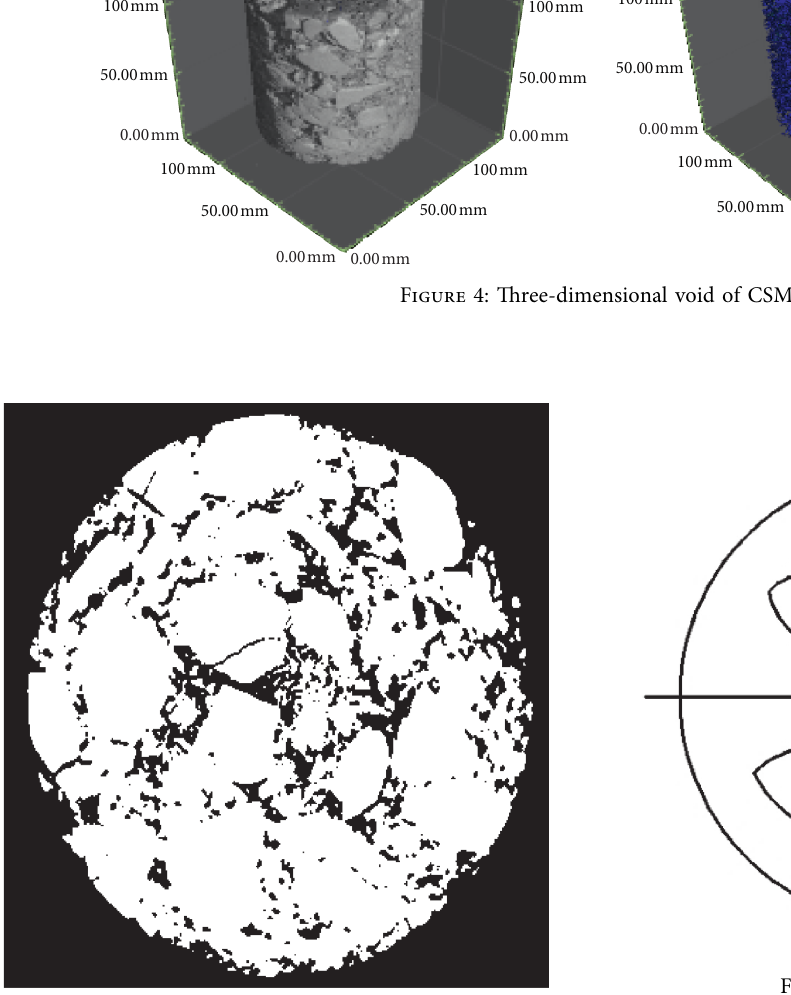
Figure 5: Binary picture of coarse aggregate.